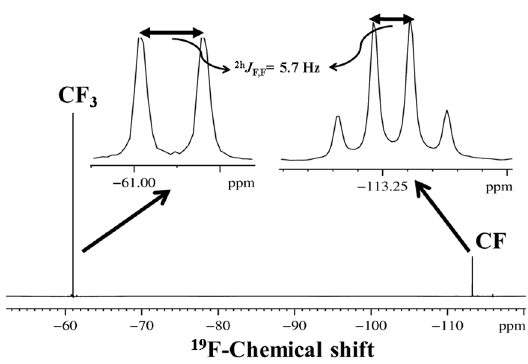
Figure 12. 376.7 MHz 19 F{ 1 H} NMR spectrum of molecule 5 showing 2h J FF through-space coupling.